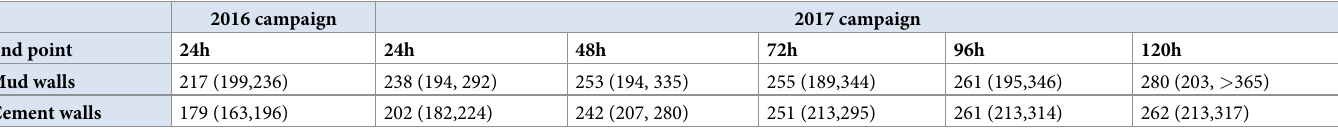
Table 4. Duration of optimal IRS residual efficacy (i.e. mosquito mortality > 80%) in mud and cement walls, as estimated through WHO cone bioassays and expressed in